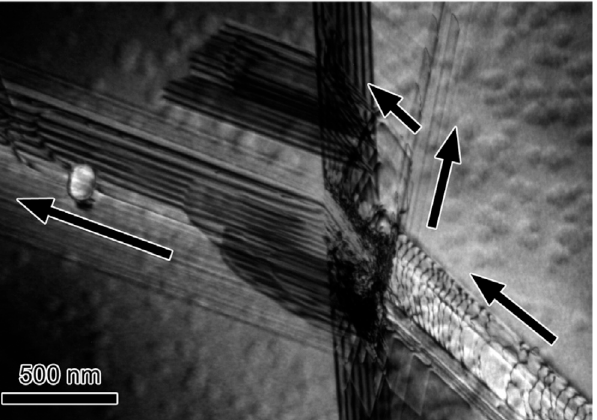
Figure 13. TEM image of the dislocation–grain boundary interaction with direct and indirect transmission and reflection. (Reprinted from Reference [93], with permission from Elsevier).